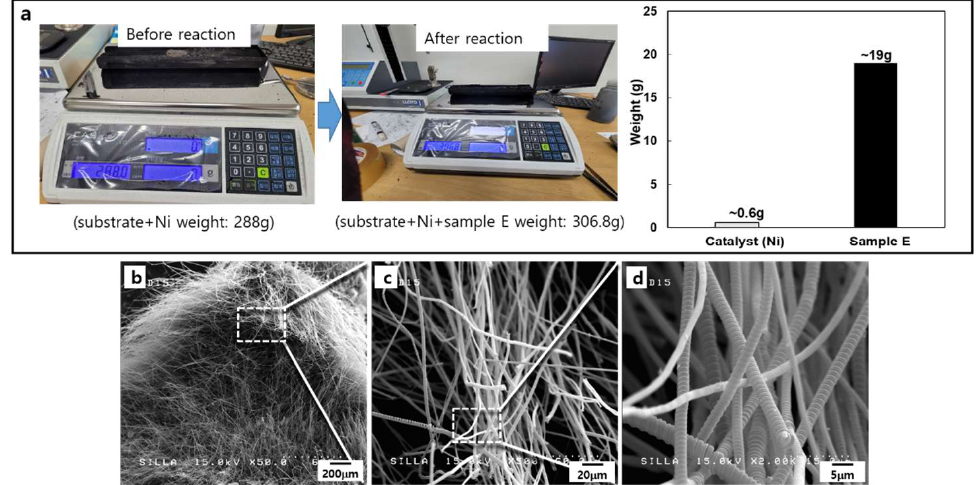
Figure 4. ( a ) Optical photograph for the weighting of sample E, ( b ) FESEM image of sample E, ( c ) magnified-FESEM image of ( b ), and ( d ) high magnified-FESEM image of ( c